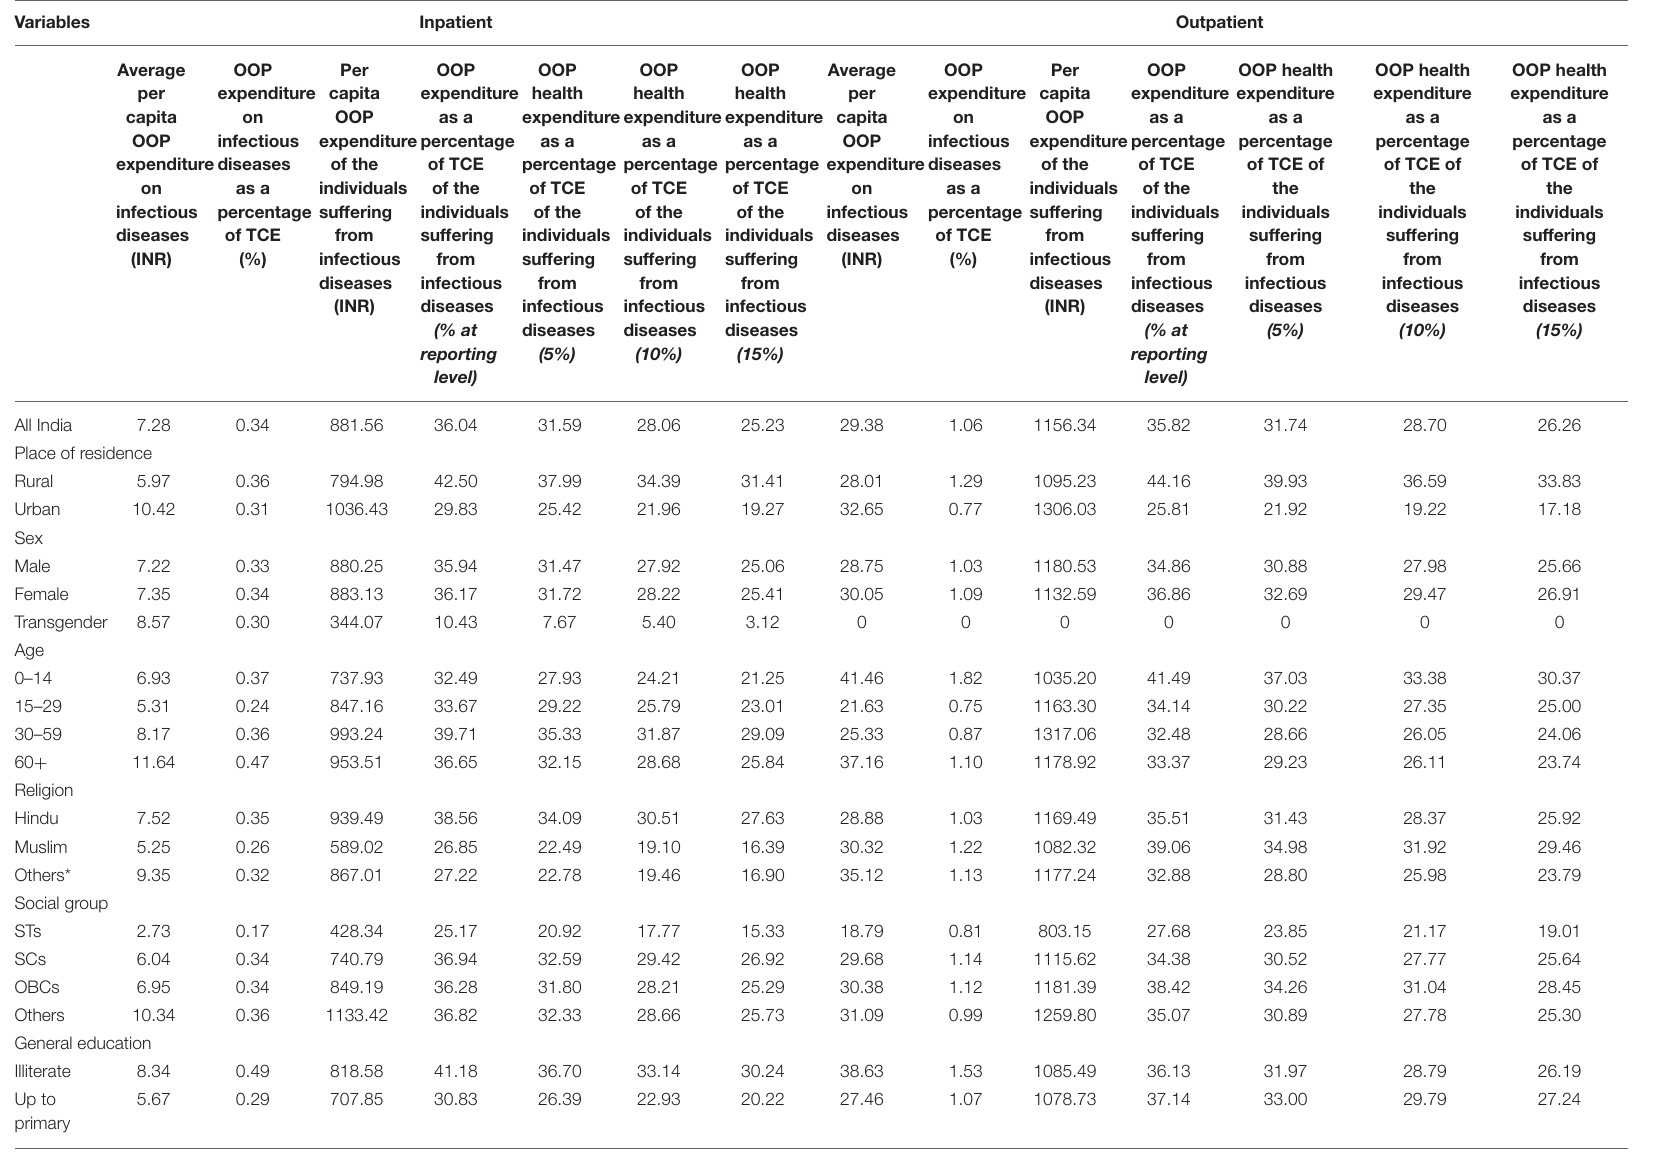
TABLE 3 | Socio-economic and demographic covariates in the level of out-of-pocket (OOP) expenditure as a share of total consumption expenditure (TCE) on infectious diseases in India (2017–18). Variables